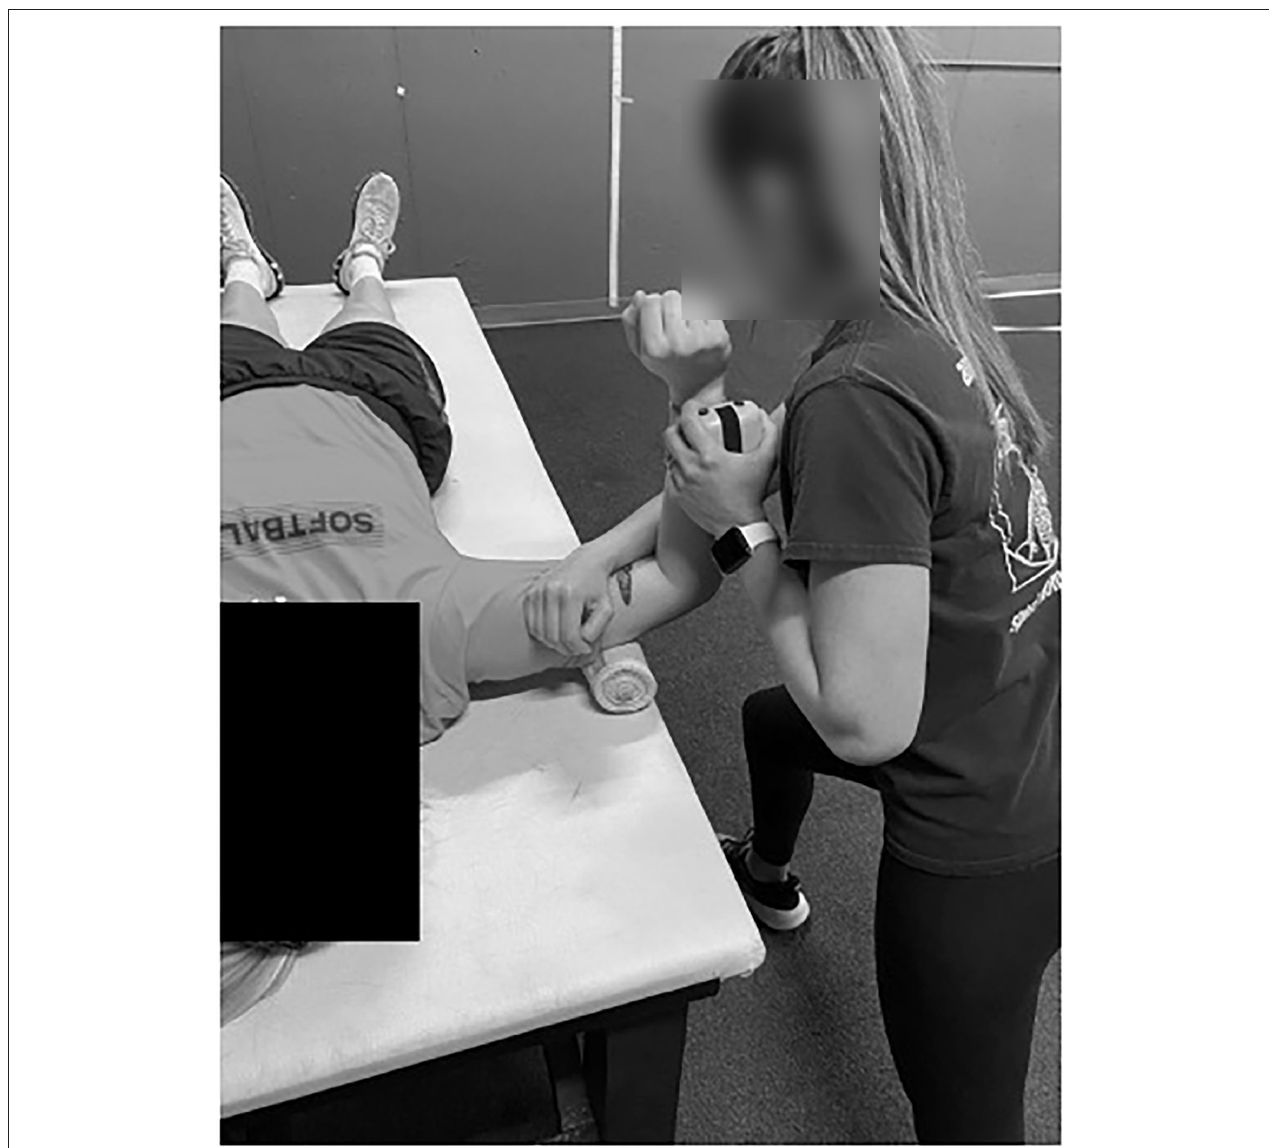
FIGURE 5 | Shoulder ER ISO